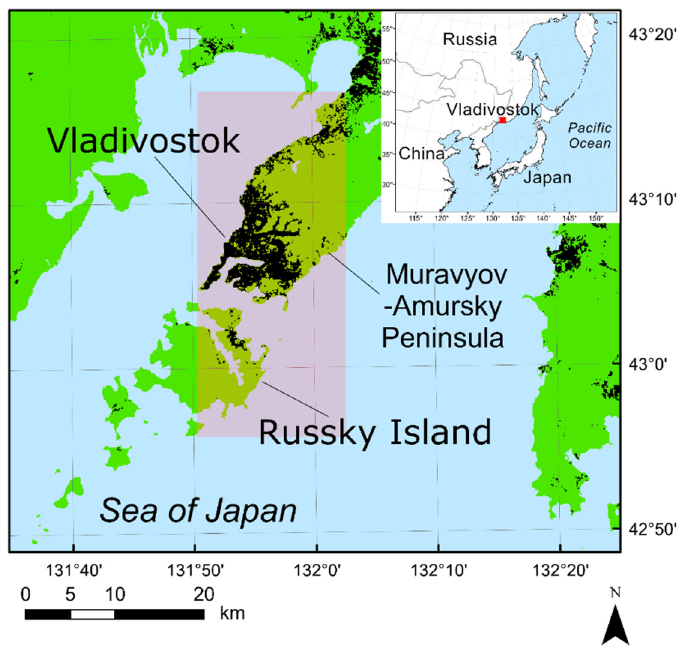
Figure 1. The study area, urbanized territories highlighted in black and the area of interest indicated by a red polygon.